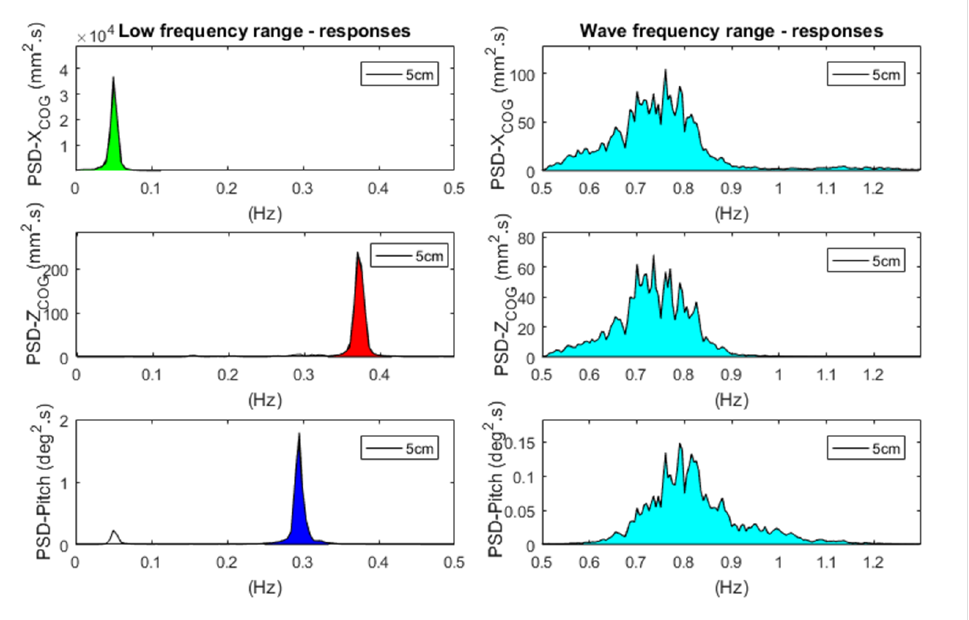
Figure 2. Motion responses to JONSWAP spectrum T p = 1.29 s, H s = 5 cm: in the low frequency range ( left ) and in the wave frequency range ( right